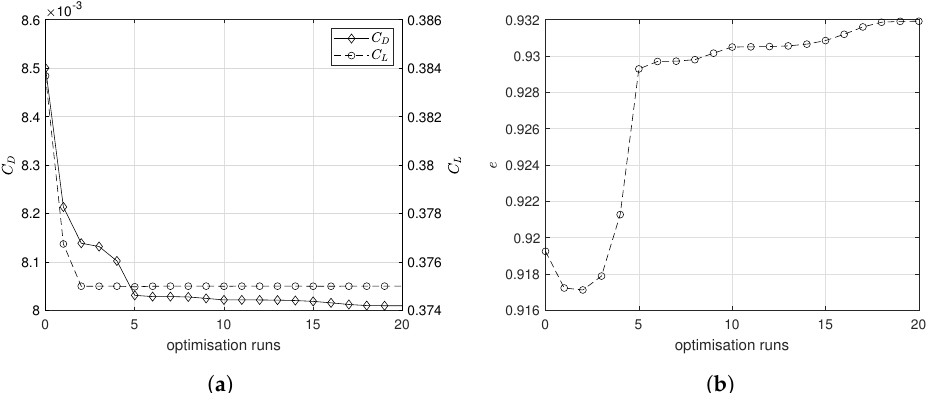
Figure 7. Twist optimisation of rectangular wing. ( a ) Coefficient of drag and lift. ( b ) Span efficiency factor.